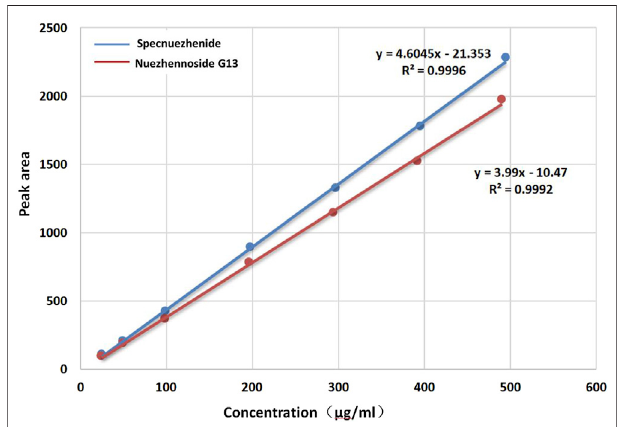
FIGURE 3 | The standard curve of Specnuezhenide and Nuezhenoside G13.